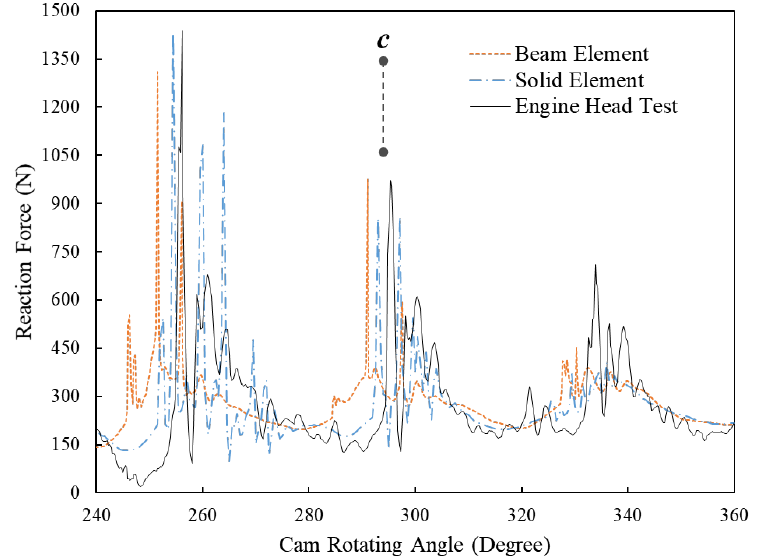
Figure 8. Comparison between the spring reaction forces at 8000 RPM engine speeds of the dynamic FE results using beam elements and solid elements and the results of the engine head test (zoom-in area between the 220-degree and 280-degree cam angles).